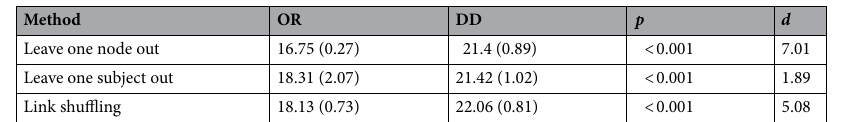
Table 2. Results from the two-tailed paired-sample permutation t -test on percolation integral comparing the OR and the DD conditions. Mean and standard deviation in parenthesis. Cohen’s d effect sizes: 0.20, small; 0.50, moderate; 0.80, large; 1.10, very